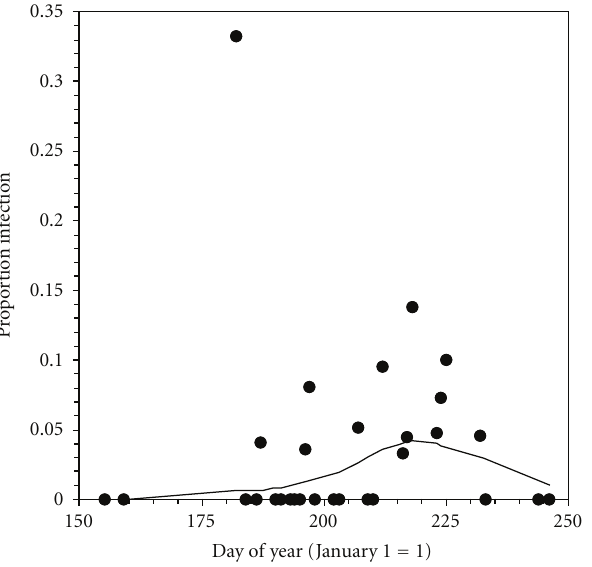
Figure 3: Proportion of bumblebees sampled from Maine blue- berry fields showing Nosema infection as determined by light microscopy. Proportions shown by day of the year between the sampling period, 4 June–3 September, 2009-2010 (data from two years pooled). The high of 33.33% is from a day with a total catch of three bees, one of which scored positive for Nosema spp.